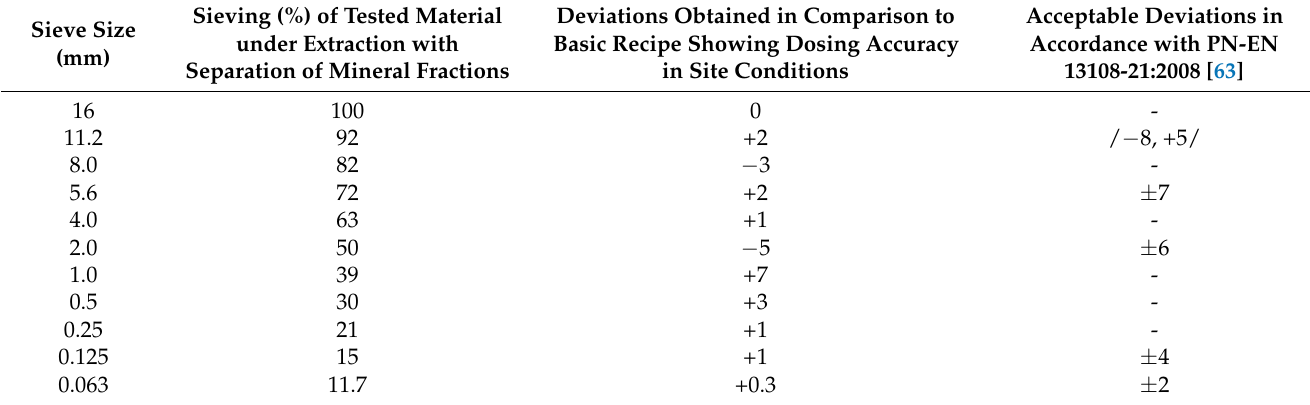
Table 7. The lab test results of AM composition of 100% granulate (average from four series taken from the test pavement). Sieve Size